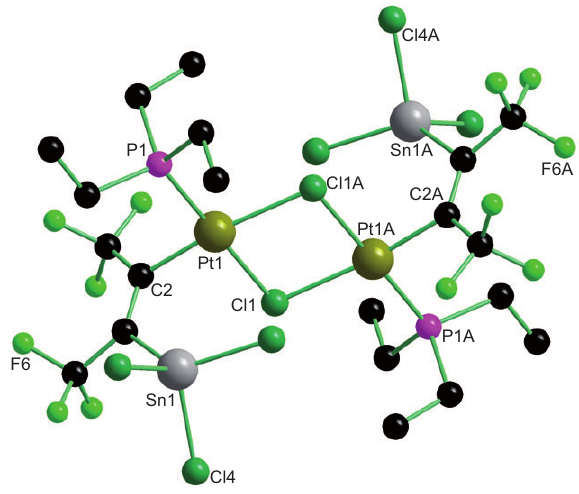
) Pt ( μ -S) Hg ( μ -Cl) 3 4 2 3 2 2